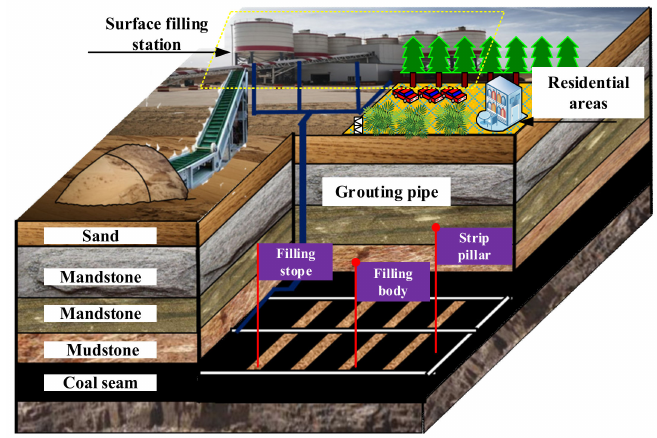
Figure 1. Three-dimensional flowchart of filling